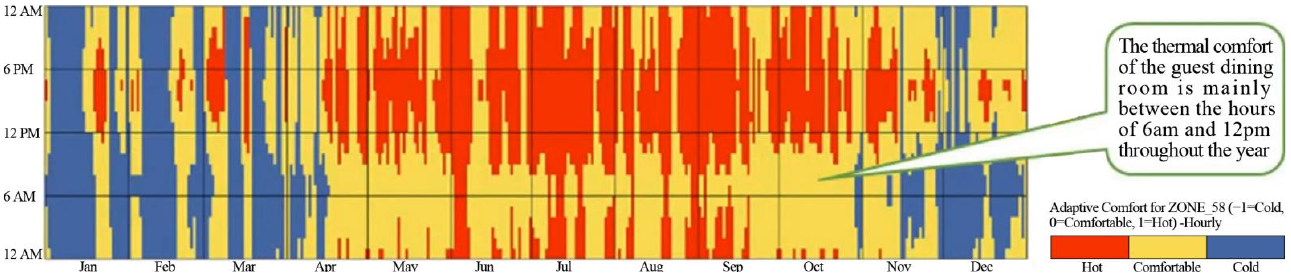
Figure 3. Natural ventilation state of the first-floor living and dining room with year-round thermal comfort state.